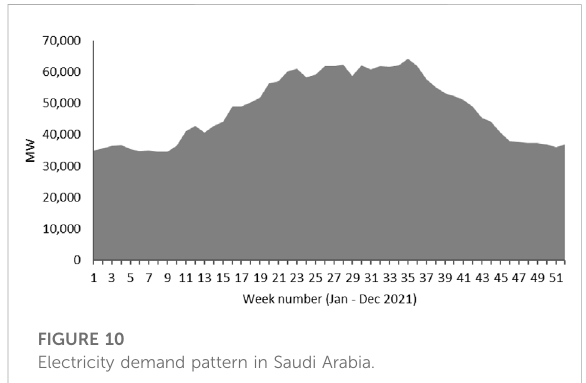
FIGURE 10 Electricity demand pattern in Saudi